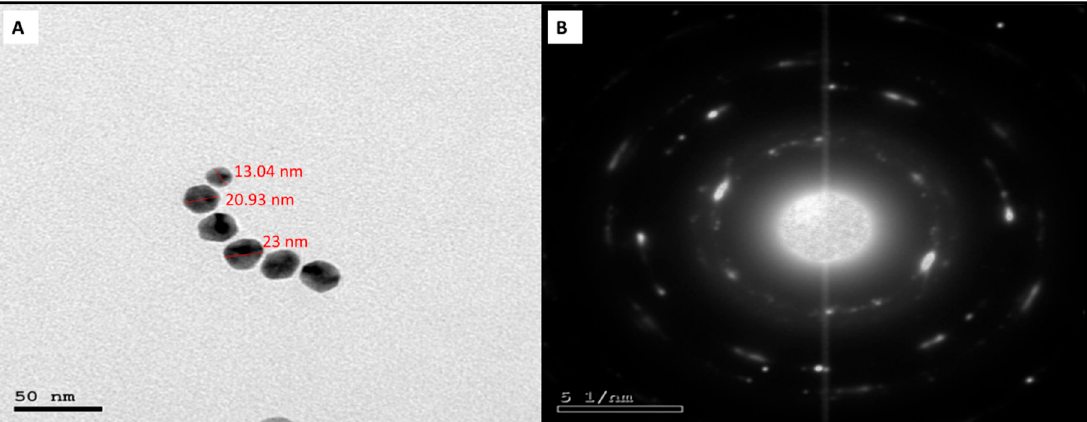
Figure 3. FTIR spectrum of AgNPs and ELLE.